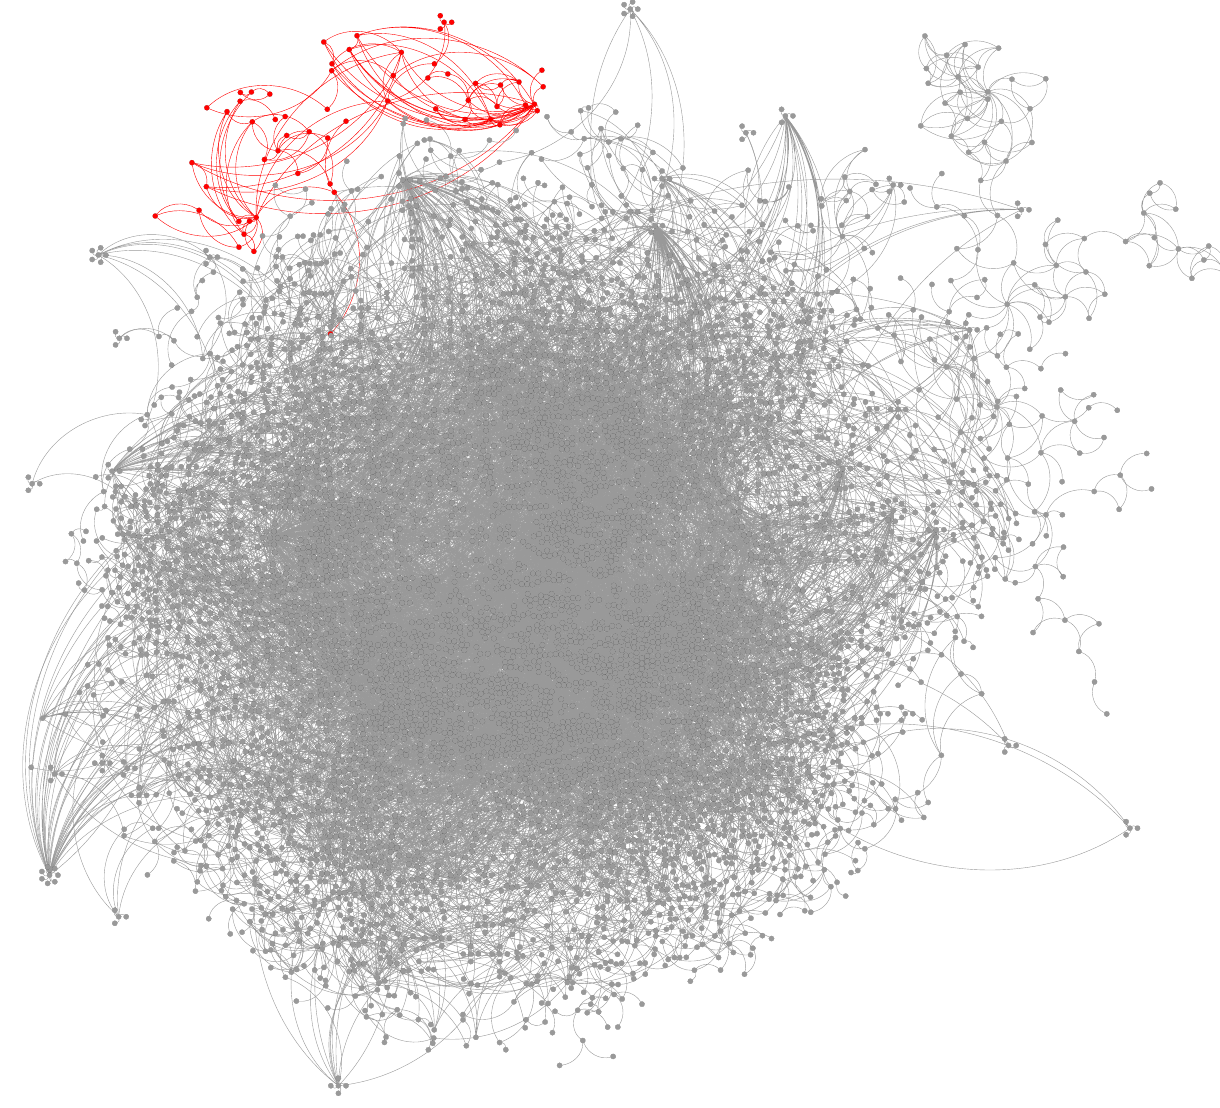
Figure 9. Local community (red) detected in the DBLP collaboration network using the proposed method. Here we show only 6342 nodes among the total 317,080 nodes (about 2% fraction) that are closest to the seed